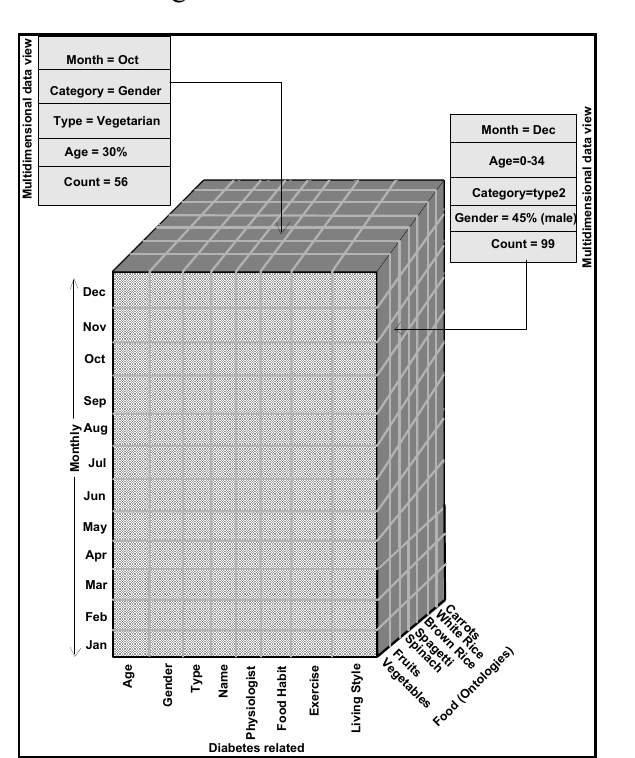
Figure 10. Data cube taken from an integrated warehouse metadata structure and extracted data